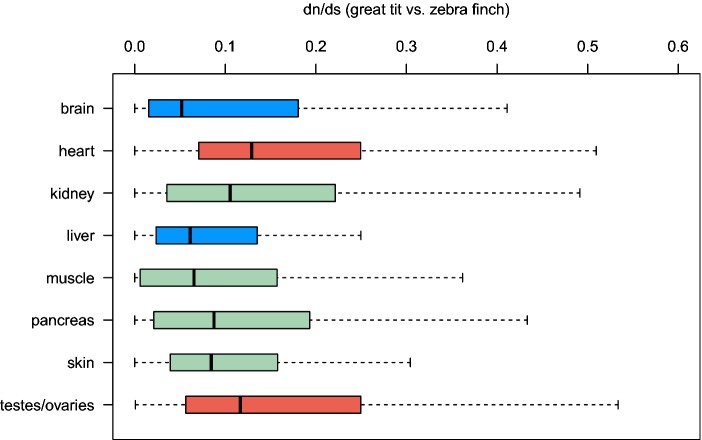
Boxplots of evolutionary rates for subsets
of genes specifically expressed in certain tissues; boxes in blue
and red denote significantly reduced and increased
dn/ds
values, respectively. Whiskers were drawn as implemented in the
R-function boxplot (see Materials and
Methods).